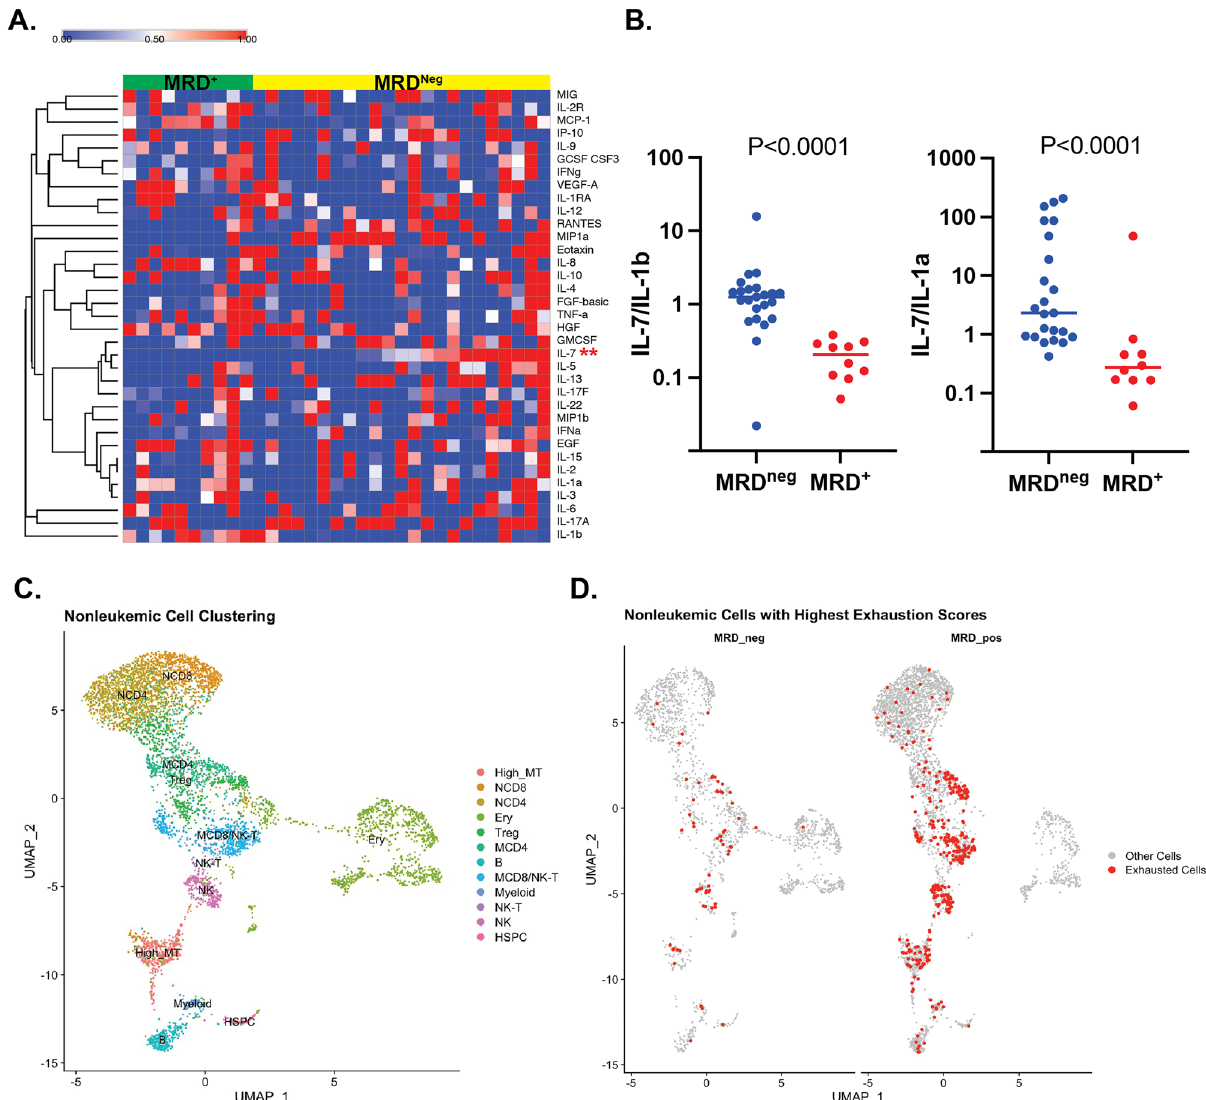
Figure 1. B-cell ALL alters the immune microenvironment. ( A ) Cytokines were measured via Luminex from the plasma of peripheral blood of children with B-ALL at the time of diagnosis. Cytokines are depicted in the heatmap relative to the median with supervised hierarchical clustering by residual disease at the end of induction chemotherapy (** P < 0.001 t test; FDR q value = 0.002; two-stage step up (Benjamini, Krieger & Yekutieli)). ( B ) The ratio of IL-7 to IL-1a and IL-1b is depicted (Mann Whitney test). ( C ) Dimensional reduction of non-leukemia cell populations using UMAP with cells colored and labeled by immune cell assignment. ( D ) Non-leukemia cells UMAP plot, split by disease outcome, with high exhaustion-scoring cells highlighted with high exhaustion scores in several cell populations including mature CD8 (MCD8) T-cells and natural killer T-cells (NK-T). Pearson’s Chi-squared test with Yates’ continuity correction used for statistical analysis demonstrates association of cells with high exhaustion score and MRD at end of induction chemotherapy ( p -value <